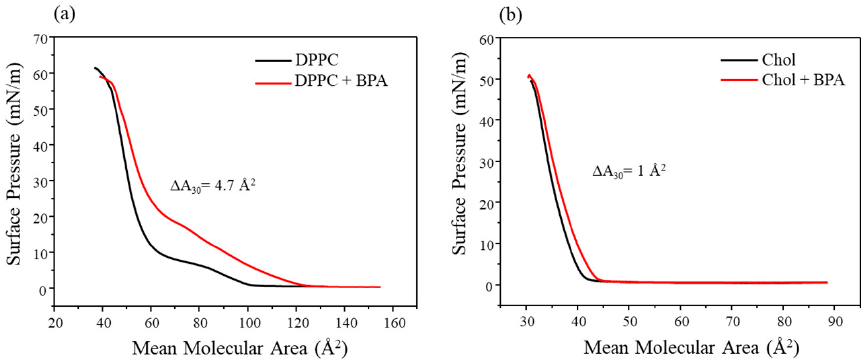
Figure 2. π -A isotherm for ( a ) DPPC and ( b ) cholesterol Langmuir films in ultrapure water subphase and the presence of BPA (1 × 10 − 5 mol/L).